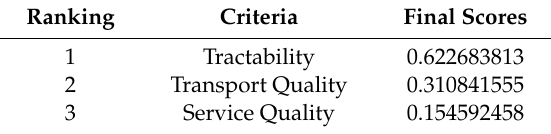
Table 3. Final fuzzy scores of the criteria for Level 2 considering branch connections.